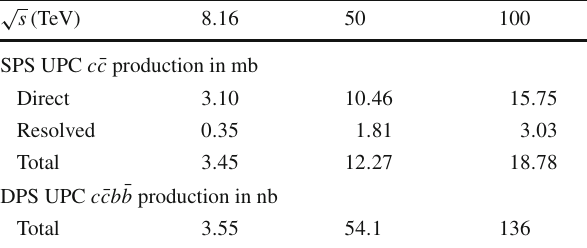
Table 1 Table with the integrated cross sections for DPS and SPS production processes